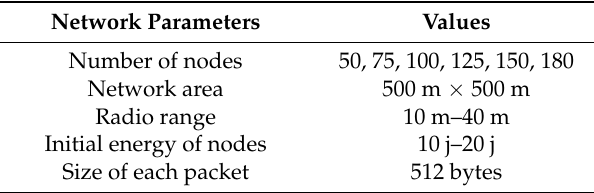
Table 4. Simulation